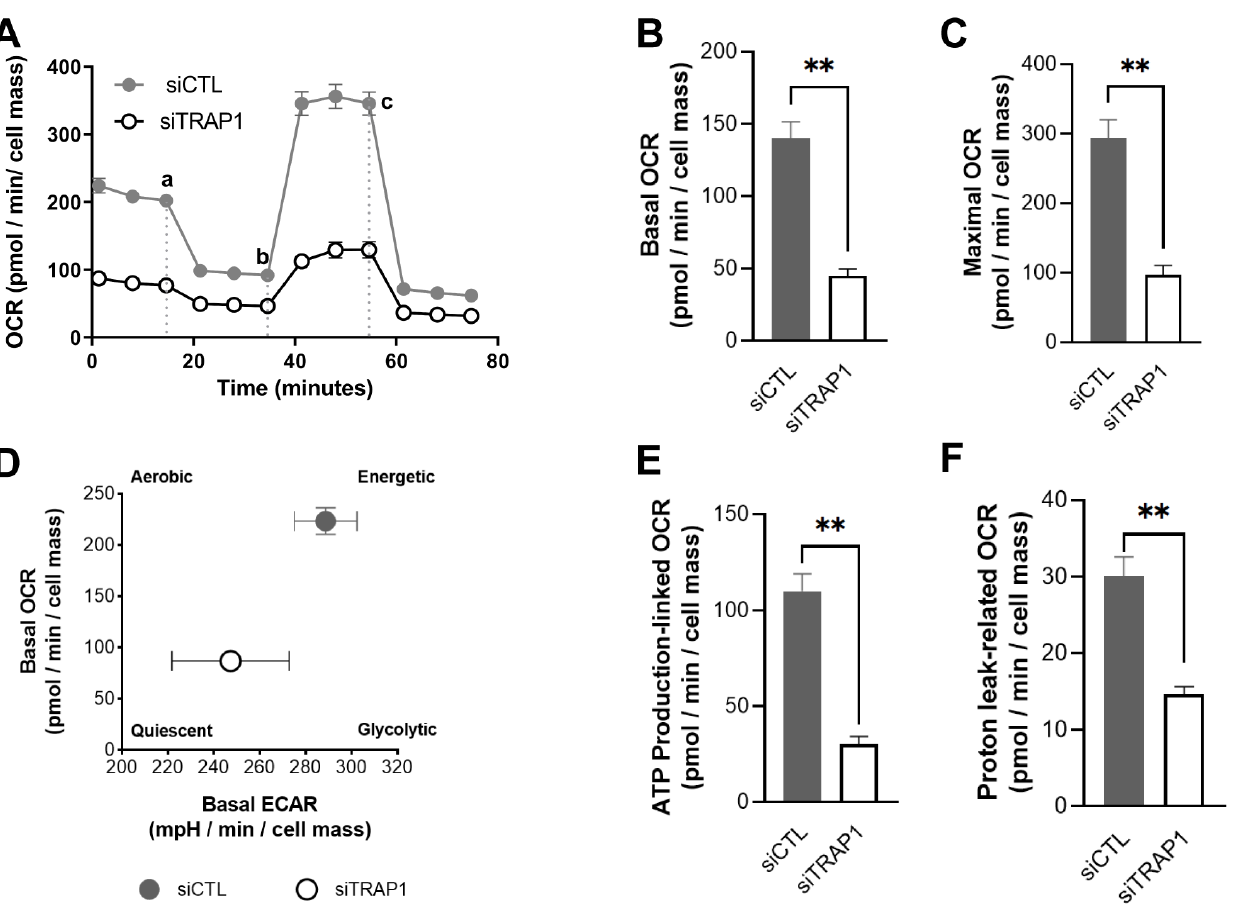
Figure 6. TRAP1 silencing drives a quiescent metabolic state. Representative images of oxygen